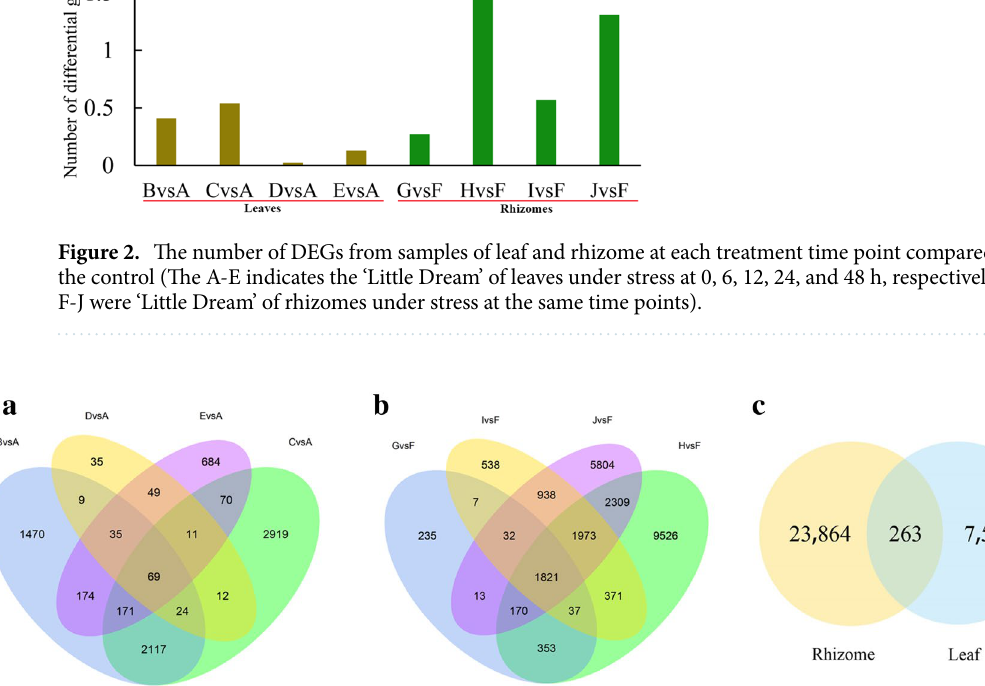
Figure 3. The Venn diagram shows the number of DEGs in samples of leaf ( a ); rhizome ( b ); leaf and rhizome ( c ) (The A-E indicates the ‘Little Dream’ of leaves under stress at 0, 6, 12, 24, and 48 h, respectively, the F-J were ‘Little Dream’ of rhizomes under stress at the same time